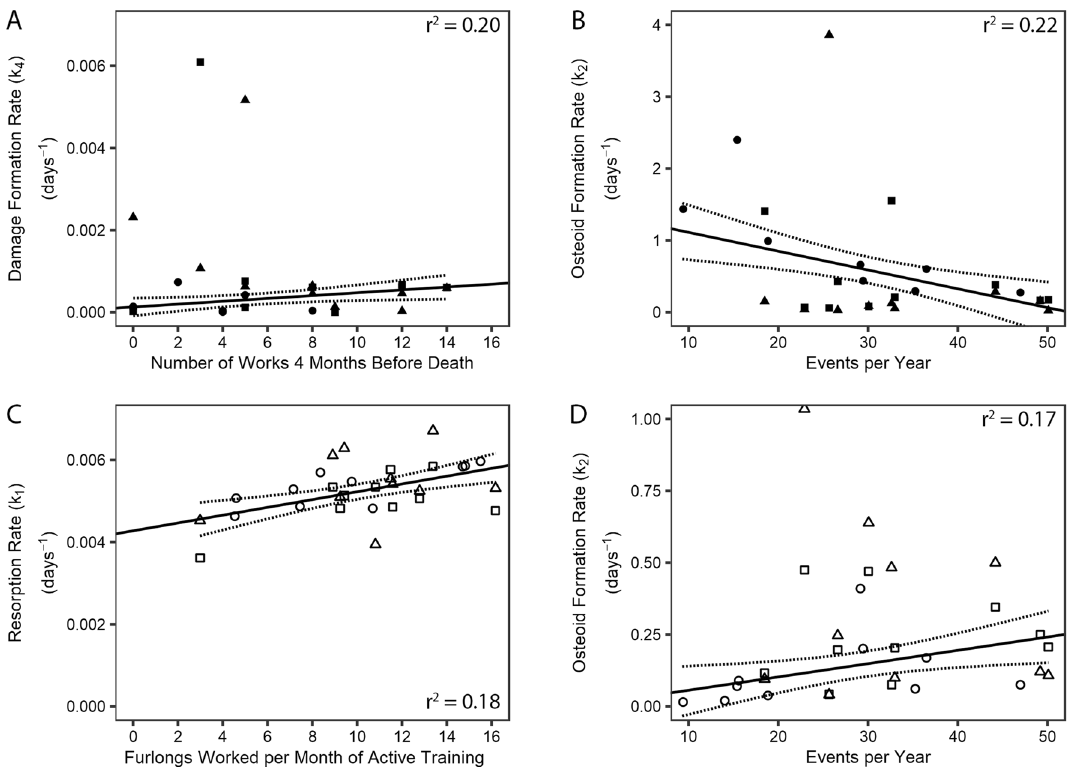
Figure 5. Significant robust linear regressions between k1, k2, k4 and exercise history variables in the damaged ROI ( A,B ) and non-damaged ROI ( C , D ); the 95% confidence intervals (dashed lines) are shown. All regressions were made using CTRL PSB (circle) and CLI PSB (square) data. The direction of increasing exercise intensity is shown by the arrow along the exercise axis. Data from FX PSB (triangle) PSBs were not used to construct